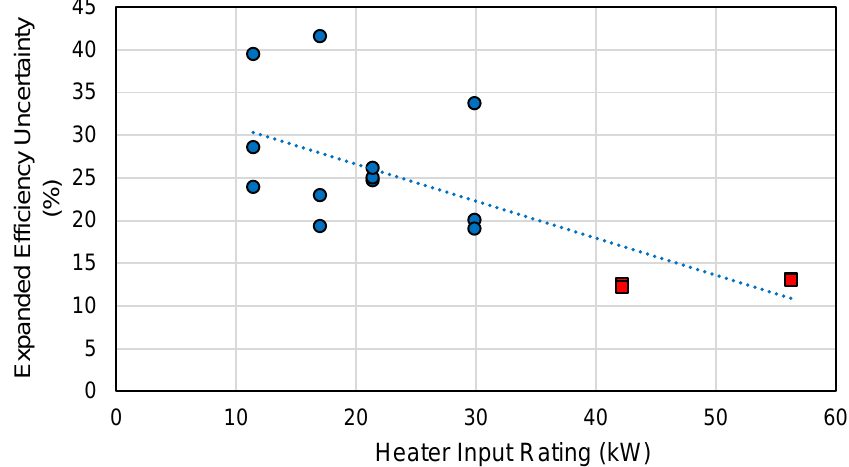
Heater Input Rating (kW)